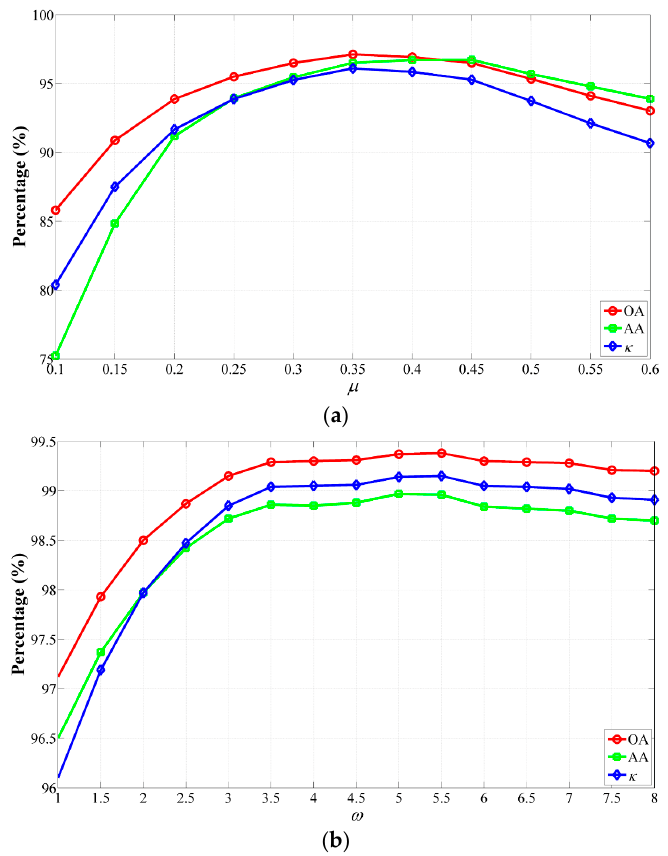
Figure 9. Analysis of the impact of μ and ω on classification accuracies using the CS-GC method for the University of Pavia data set. ( a ) Evolution of classification accuracies against different values of μ ; ( b ) evaluation of classification accuracies against different values of ω .